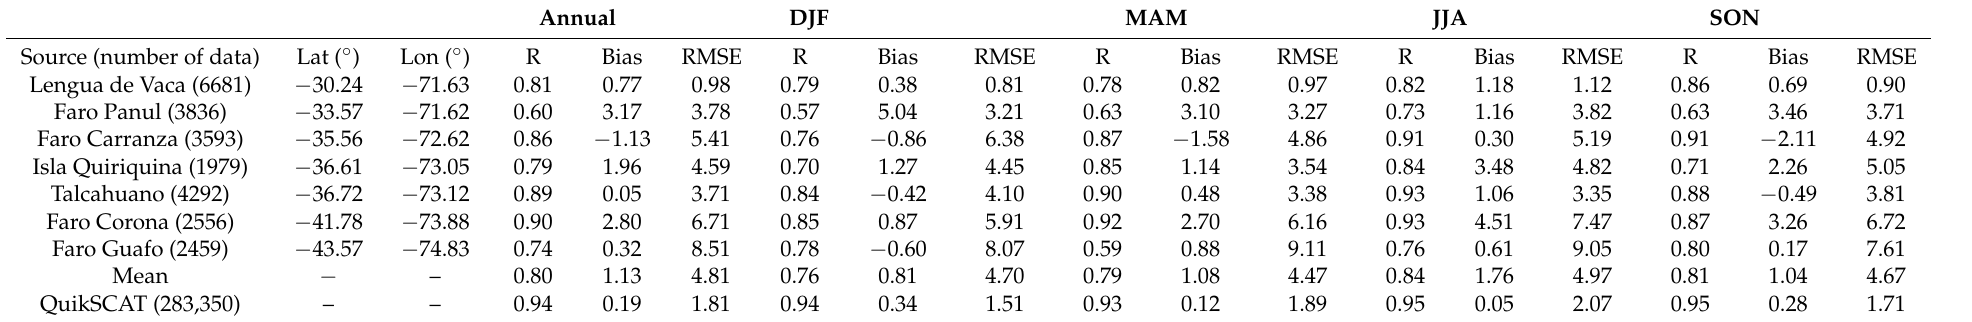
Table 2. Statistics from wind data comparison between reanalysis, measurements and satellite data.